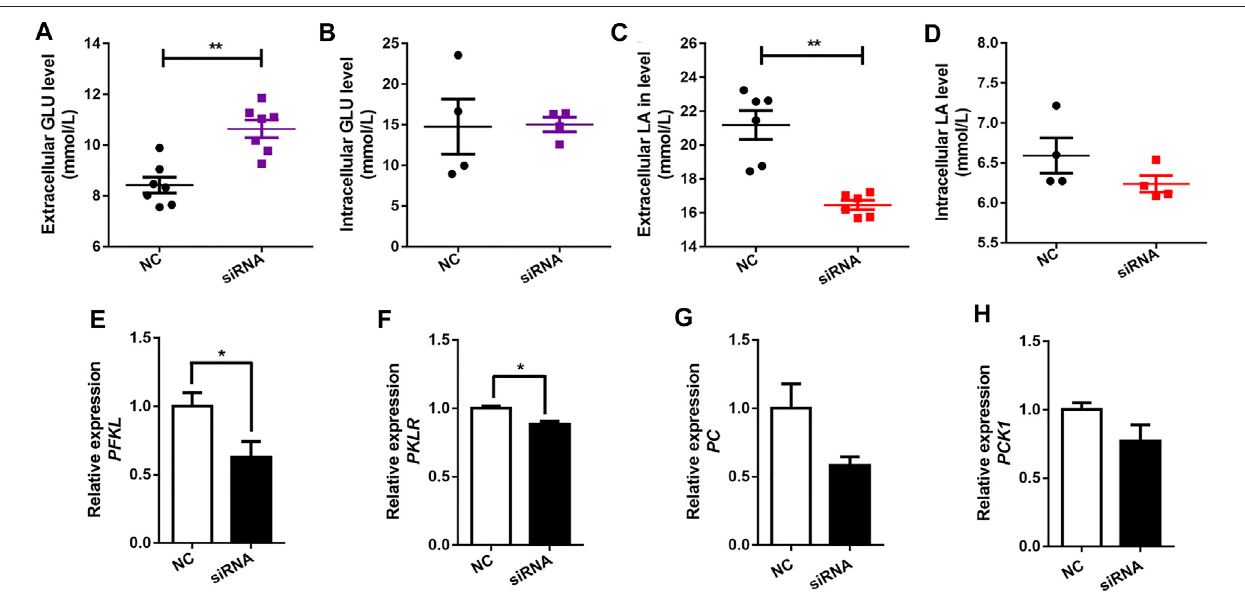
FIGURE3| Effectof SLC16A1 silencingonglucose, lactate fl uxandglucosemetabolismrelated genesinbovine hepatocytes. (A) Extracellularand (B) intracellular GLU levels; (C) Extracellular and (D) intracellular LA levels. (E) PFKL , (F) PKLR , glycolysis; (G) PC , (H) PCK1 , gluconeogenesis. siRNA, SLC16A1 ; NC, negative control